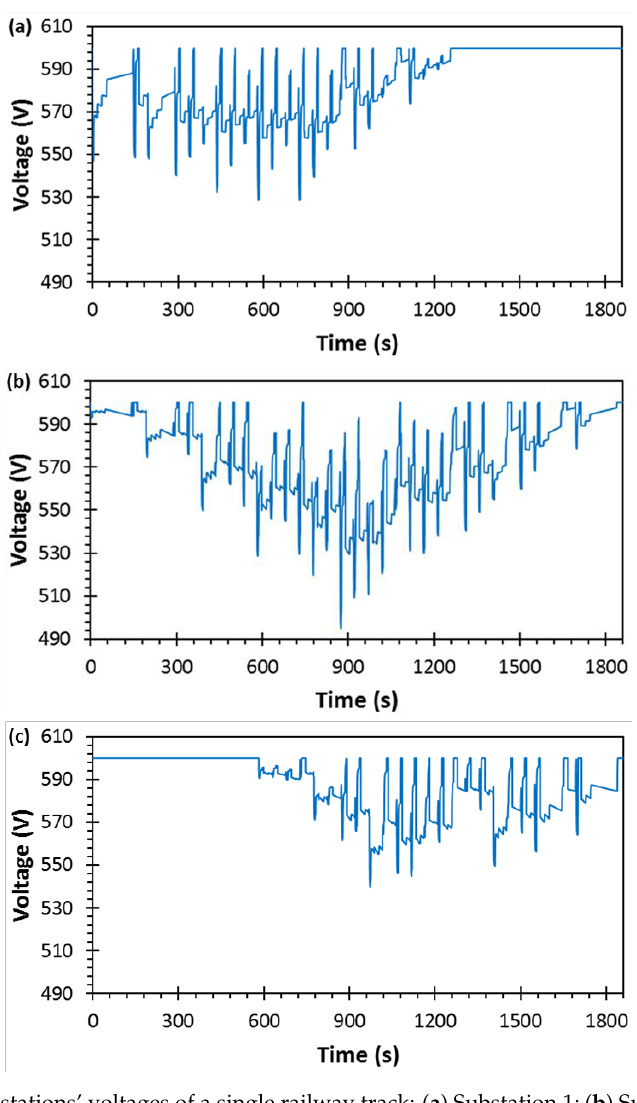
Figure 13. The substations’ voltages of a single railway track: ( a ) Substation 1; ( b ) Substation 2; and ( c ) Substation 3.